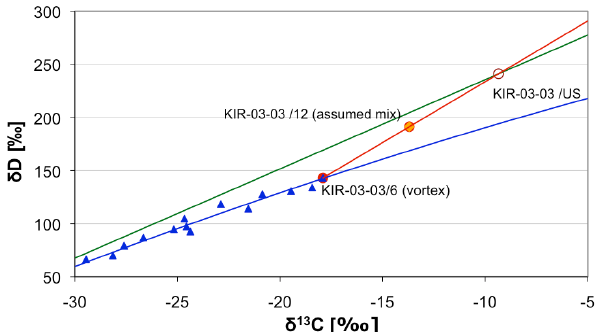
Fig. 9. Assuming that KIR-03-03/12 is the result of an end-member Figure 12: Assuming that KIR-03-03/12 is the result of an end-member mixing process between 879 mixing process between vortex air (blue) and upper stratospheric vortex air (blue) and upper stratospheric air outside the vortex (green), an appropriate upper 880 air outside the vortex (green), an appropriate upper stratospheric stratospheric member KIR-03-03/US can be constructed. 881 member KIR-03-03/US can be constructed. Note that the vortex and upper stratospheric end members may shift along the respective